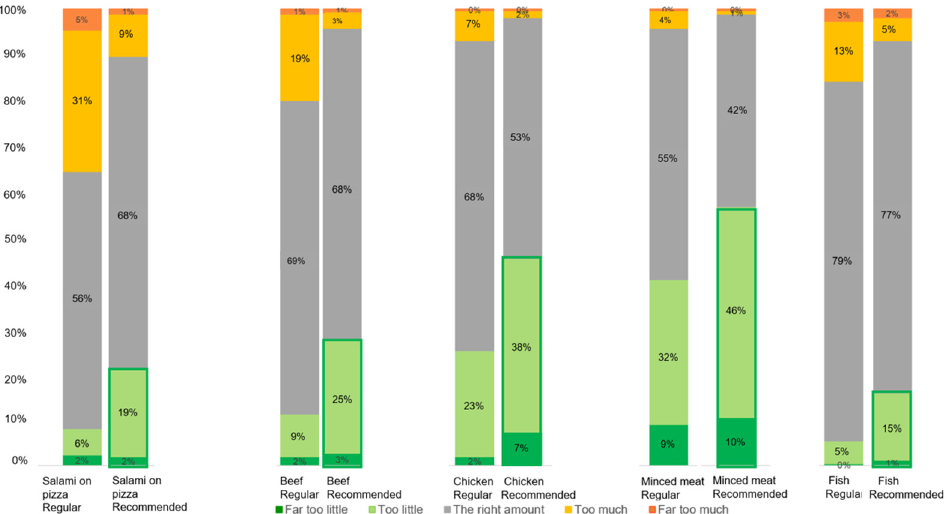
Figure 3. Bar plots of the perceived amount of meat (from “far too little” to “far too much”) in the regular and recommended portions of each of the five meals.